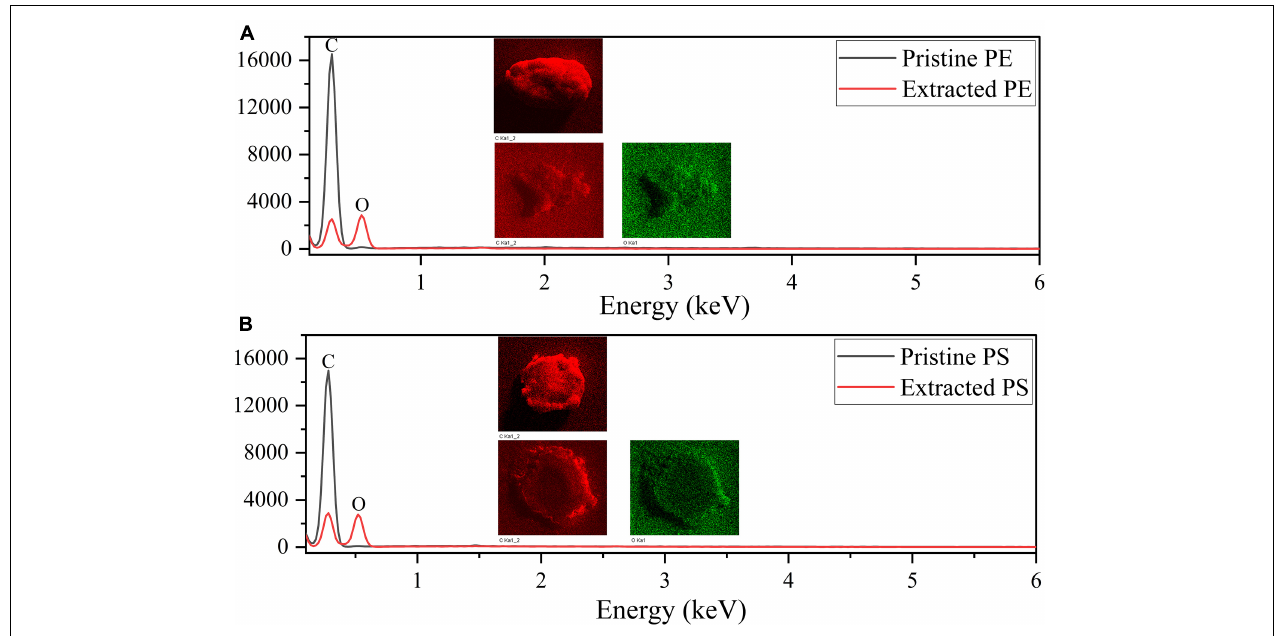
FIGURE 5 | EDS spectra of PE MPs (A) and PS MPs (B) .